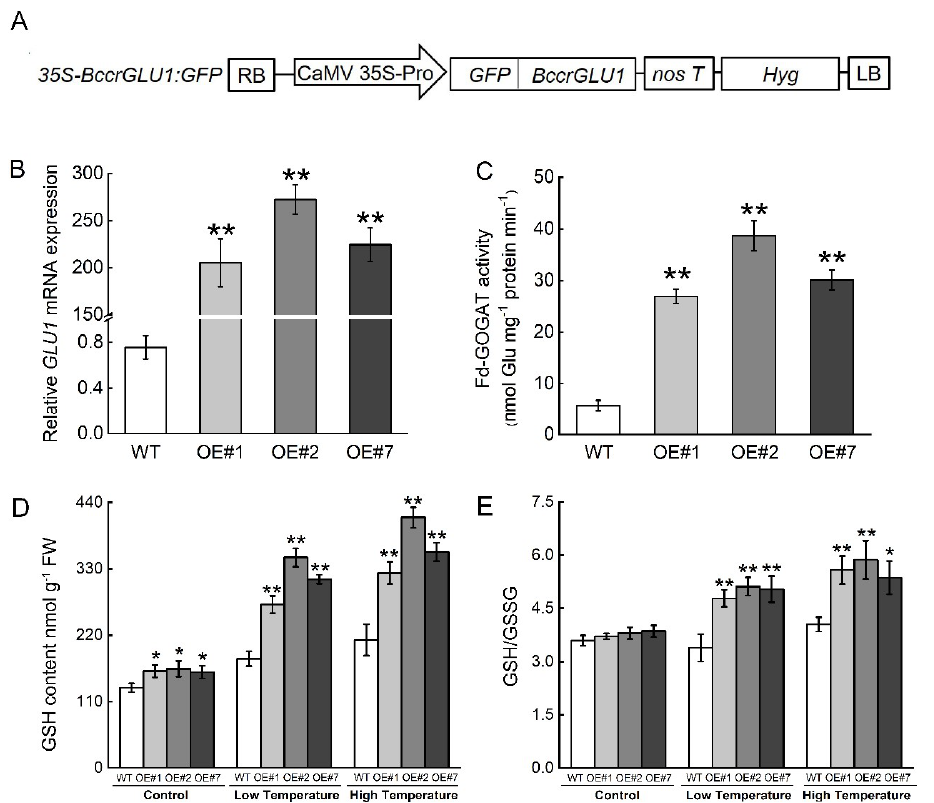
Figure 7. Schematic diagram of 35S-BccrGLU1:GFP fusion protein construct and physiological changes associated with temperature stress response in wild-type (WT) and overexpressed (OE) lines of Arabidopsis plants. ( A ) Schematic diagram of 35S-ccrGLU1:GFP fusion protein construct. ( B ) Relative expression of BccrGLU1 in T3 transgenic plants. WT: Col-0; OE#1, OE#2, OE#7. T3 plants with BccrGLU1 on the AtCol-0 background. ( C ) Fd-GOGAT activity in WT and OE lines. ( D ) Glutathione (GSH) content in leaves. (E) GSH / oxidized glutathione (GSSG) ratio in leaves. Values represent mean ± SE ( n = 3). ** and * indicate significant di ff erences from wild-type plants at the level of p < 0.01 and p < 0.05 respectively, using Student’s t-test.